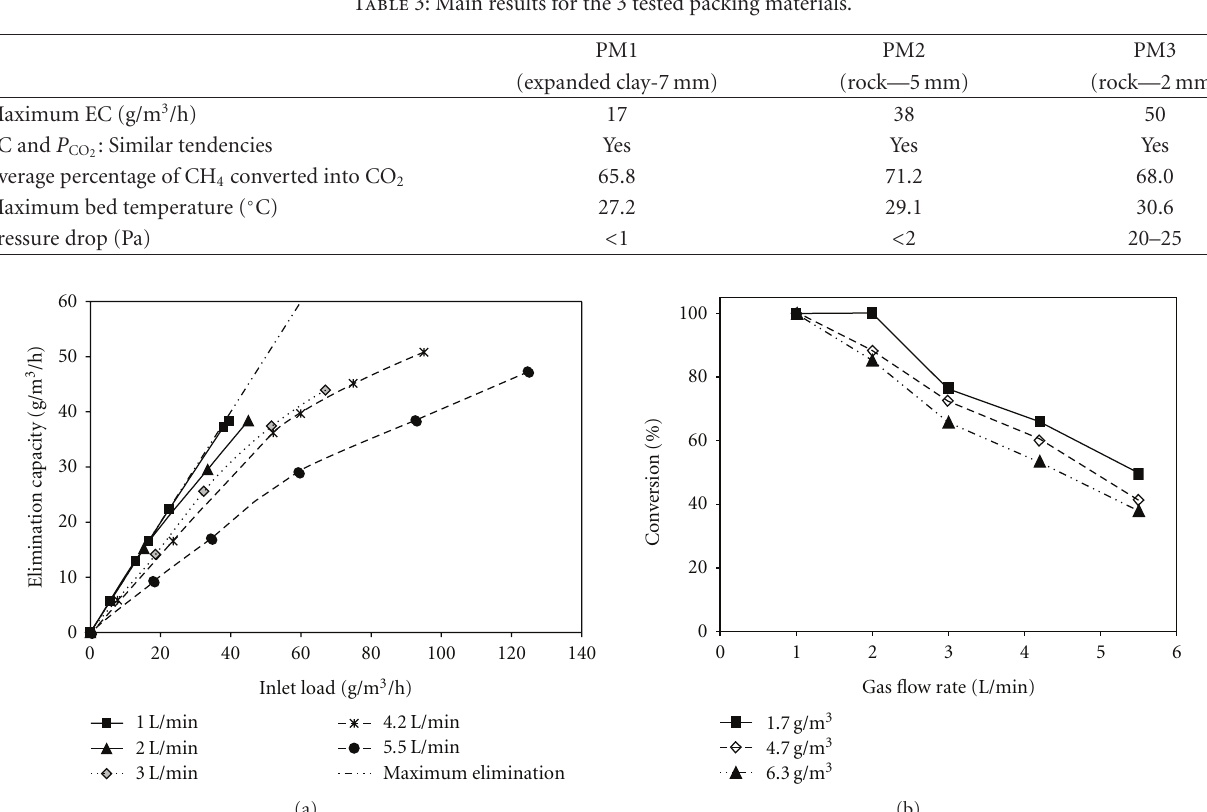
Table 3: Main results for the 3 tested packing materials.